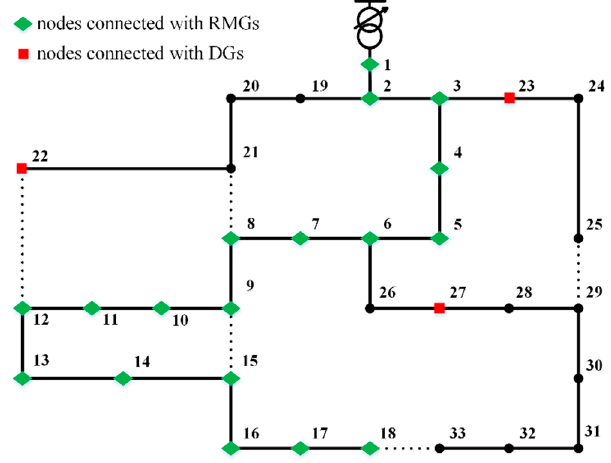
Figure 6. Modified IEEE-33 bus distribution system.